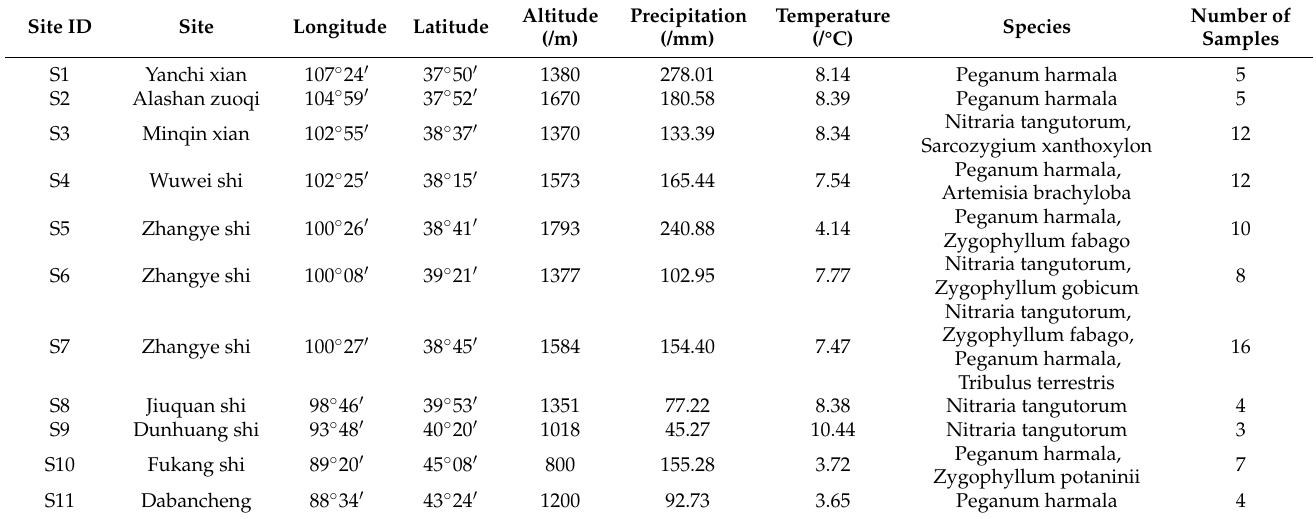
Table 1. Sampling sites of Zygophyllaceae plants in arid and semi-arid regions of